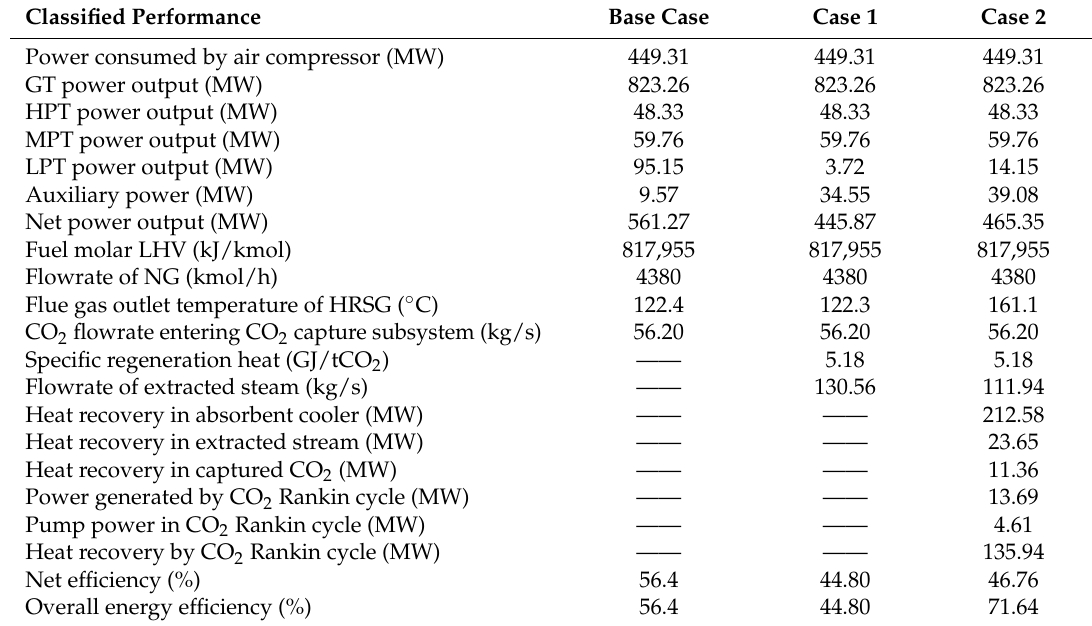
Table 2. Thermal performance comparison for Base case, Case 1 and Case